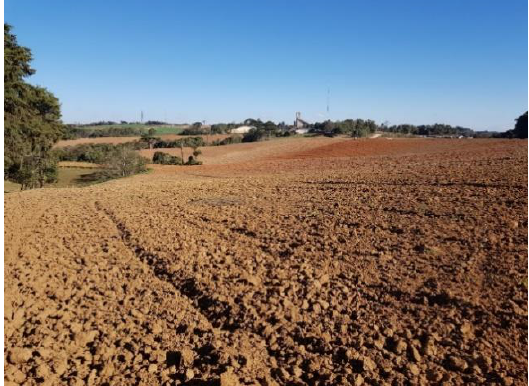
Figure 7. Typical arable land in Passaúna catchment. Figure 8. Typical arable land in Passa ú na